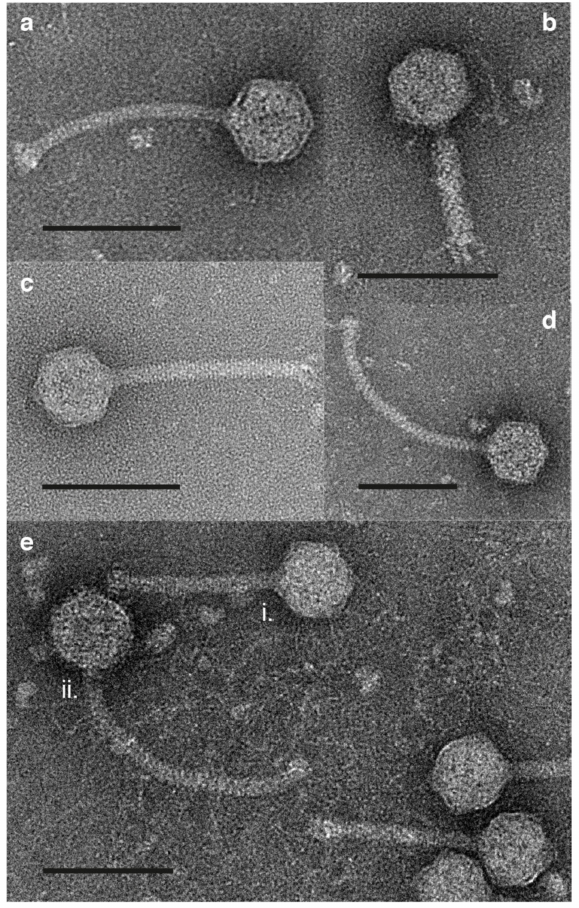
Figure 6. Negatively stained transmission electron micrographs of phage particles. ( a ) tant8-1, (b ) pippi8-1, ( c ) mumin9-1, ( d ) laban6-1, ( e ) (i) tooticki6-1 and ( e ) (ii) laban6-1. Scale bars are 100